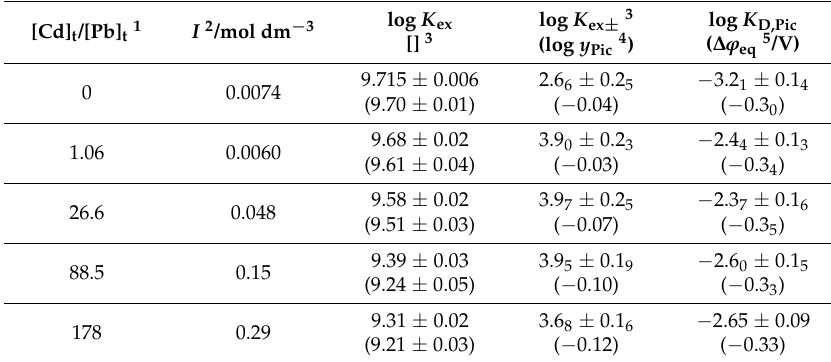
Table 1. Basic data for the Pb(II) extraction by B18C6 from the water phase with co-presence of Cd(NO 3 ) 2 into Bz at 298 K.